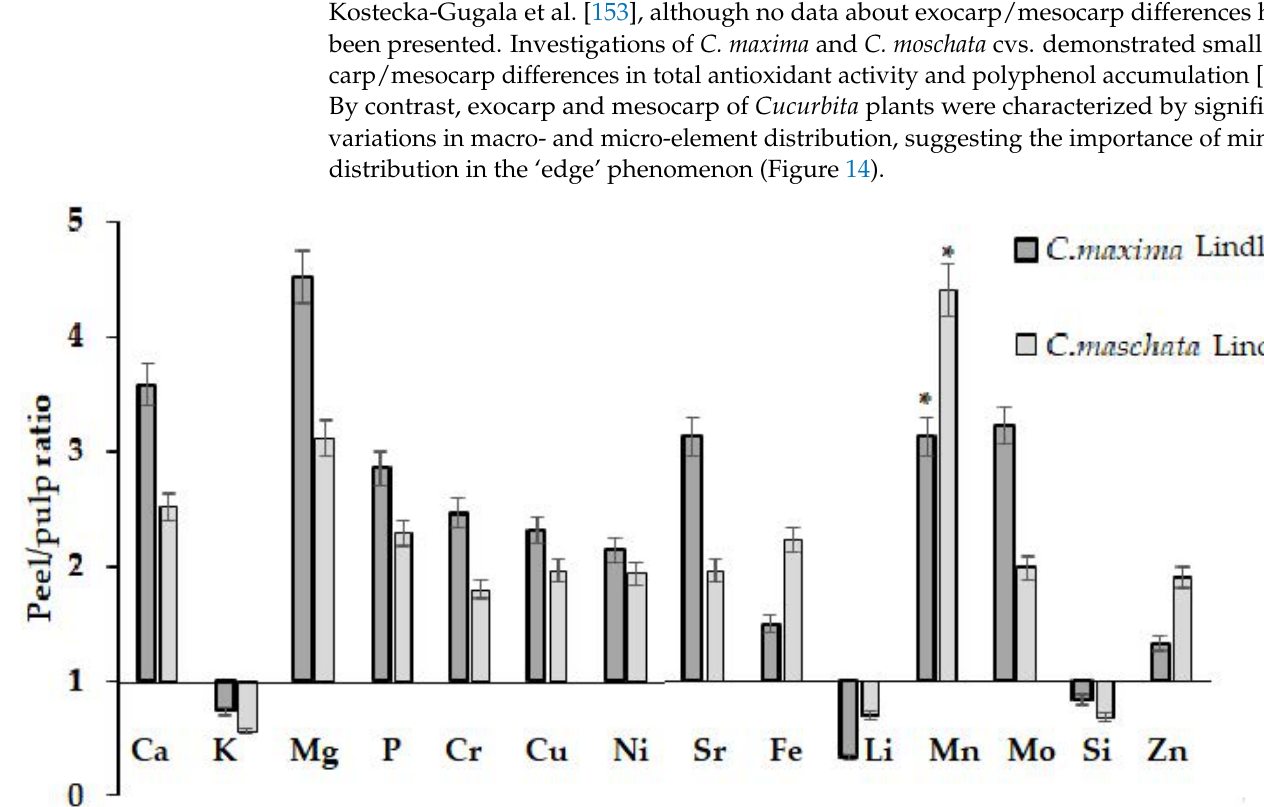
Figure 14. Exocarp/mesocarp differences in minerals accumulation. (* values are halved). Notably, the biodiversity effect in the ‘bordering tissues’ has been clearly shown in the ex- ocarp/mesocarp mineral distribution of Cucurbita maxima Lindl. and Cucurbita moschata Lindl. fruit (Figure 14) [154]. Only K, Li and Si predominate in fruit mesocarp, while other el- ement concentrations were significantly higher in exocarp, especially Mn. The analysis of the relationship between elements in Cucurbita fruit revealed the highest correlations (r = 0.85–0.98) between Ca, Sr, Cr and Ni [154]. The variations in pumpkin exocarp uti- lization are closely connected with the main characteristics of the bordering plant parts, combining high antioxidant and adsorption activity (Table